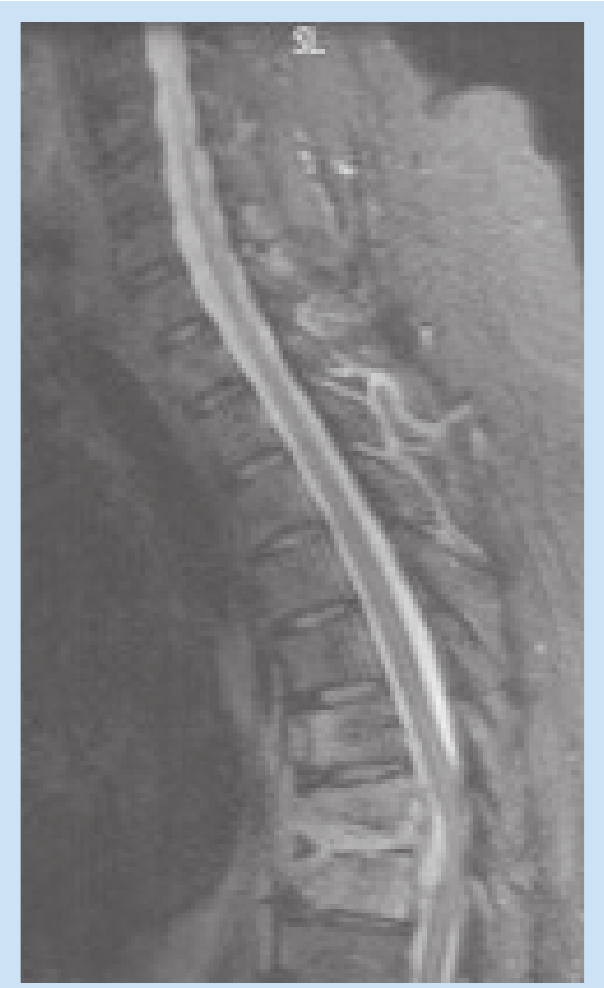
Fig 3c. Sagittal STIR image. High signal in affected vertebrae.